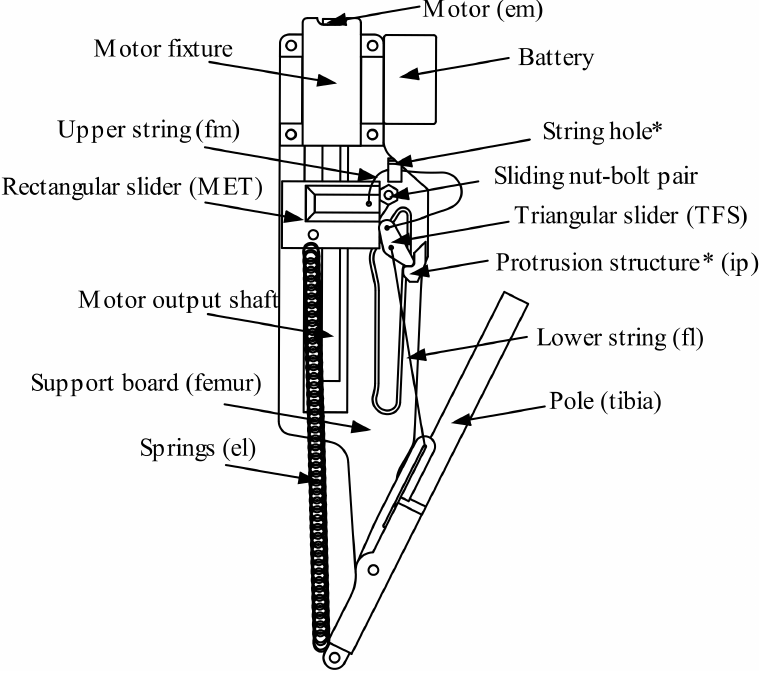
Figure 2. Naming of parts in a side view of the device. In brackets are biological structures in corresponds. *: structures on support board